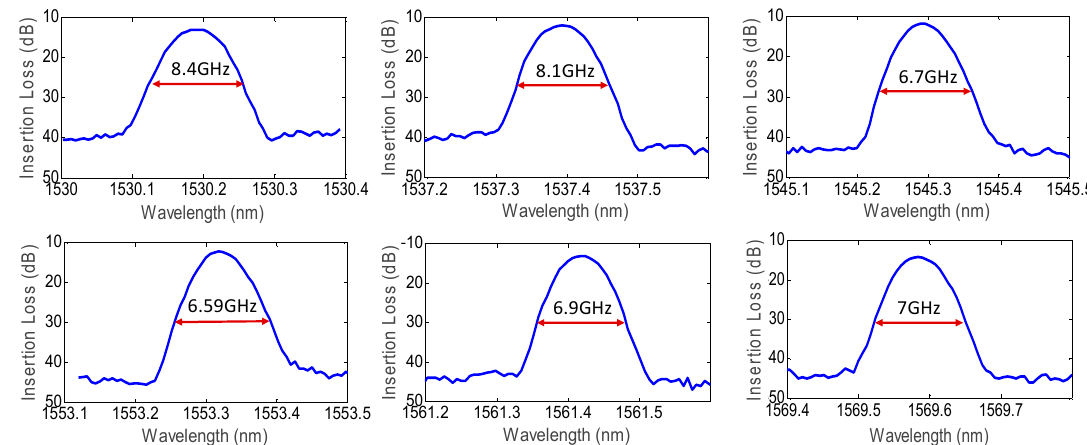
Figure 7. Measured minimum bandwidths in the C-band at the central wavelengths of 196 THz (1529.553 nm), 195 THz (1537.397 nm), 194 THz (1545.322 nm), 193THz (1553.329 nm), 192 THz (1561.419 nm) and 191 THz (1569.594 nm), respectively.